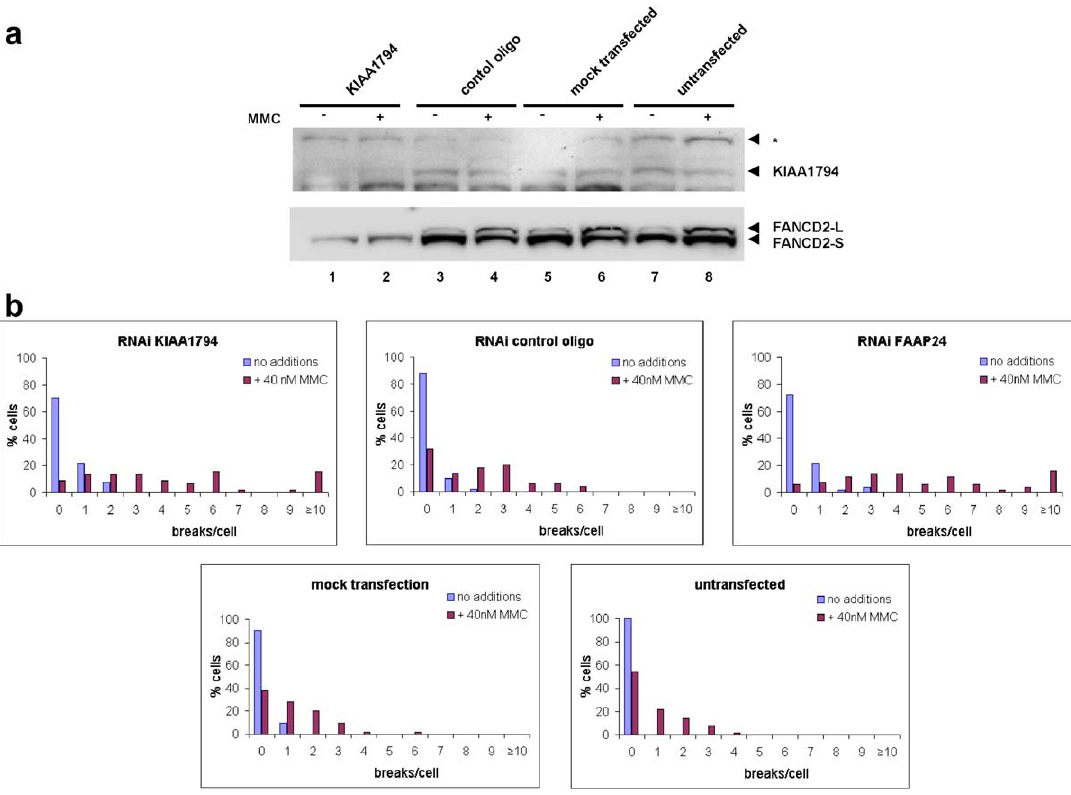
Fig. 3. Effect of KIAA1794 knockdown on FANCD2 ubiquitination and chromosomal instability in HeLa cells. (a) Effect of KIAA1794-specific siRNA oligo transfection (lane 1 and 2) on KIAA1794 protein levels and FANCD2 monoubiquitination (lanes 3–8 are controls, as indicated). Cells were treated with MMC ( + ) or not treated ( − ). FANCD2 was visualized to assess its mono-ubiquitinated isoform, FANCD2-L, which is increased upon MMC treatment. FANCD2-L was not detected in lanes 1 and 2, not even after extended exposure times. (b) Chromosomal breakage analysis in the corresponding HeLa cell cultures, with or without exposure to MMC (40 nM, 24 h). Knockdown of FAAP24, a known functional component of the FA core complex was included as a positive control [1]. The increases in MMC-induced chromosomal breakage, as caused by KIAA1794-specific oligo transfection and by FAAP24-specific oligo transfection, were equally significant (compared with control oligo-transfected cells; p < 0 . 0001, 2-sample χ 2